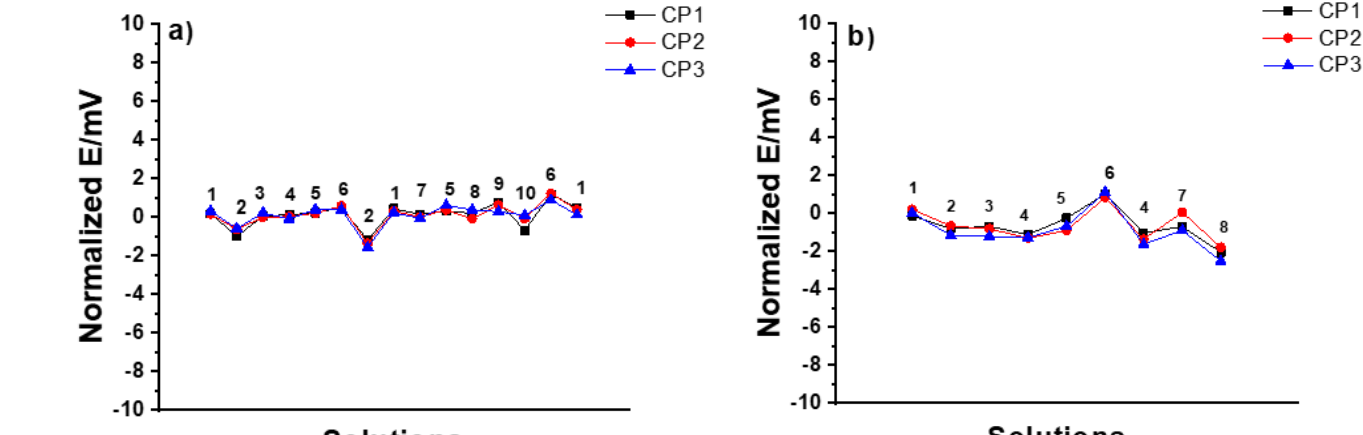
Figure 5. Results of ( a ) MSP1 (1: 3 M KCl, 2: DW, 3: 10 -2 M NaCl, 4: 10 -2 M KCl, 5: 10 -1 M KCl, 6: 10 -2